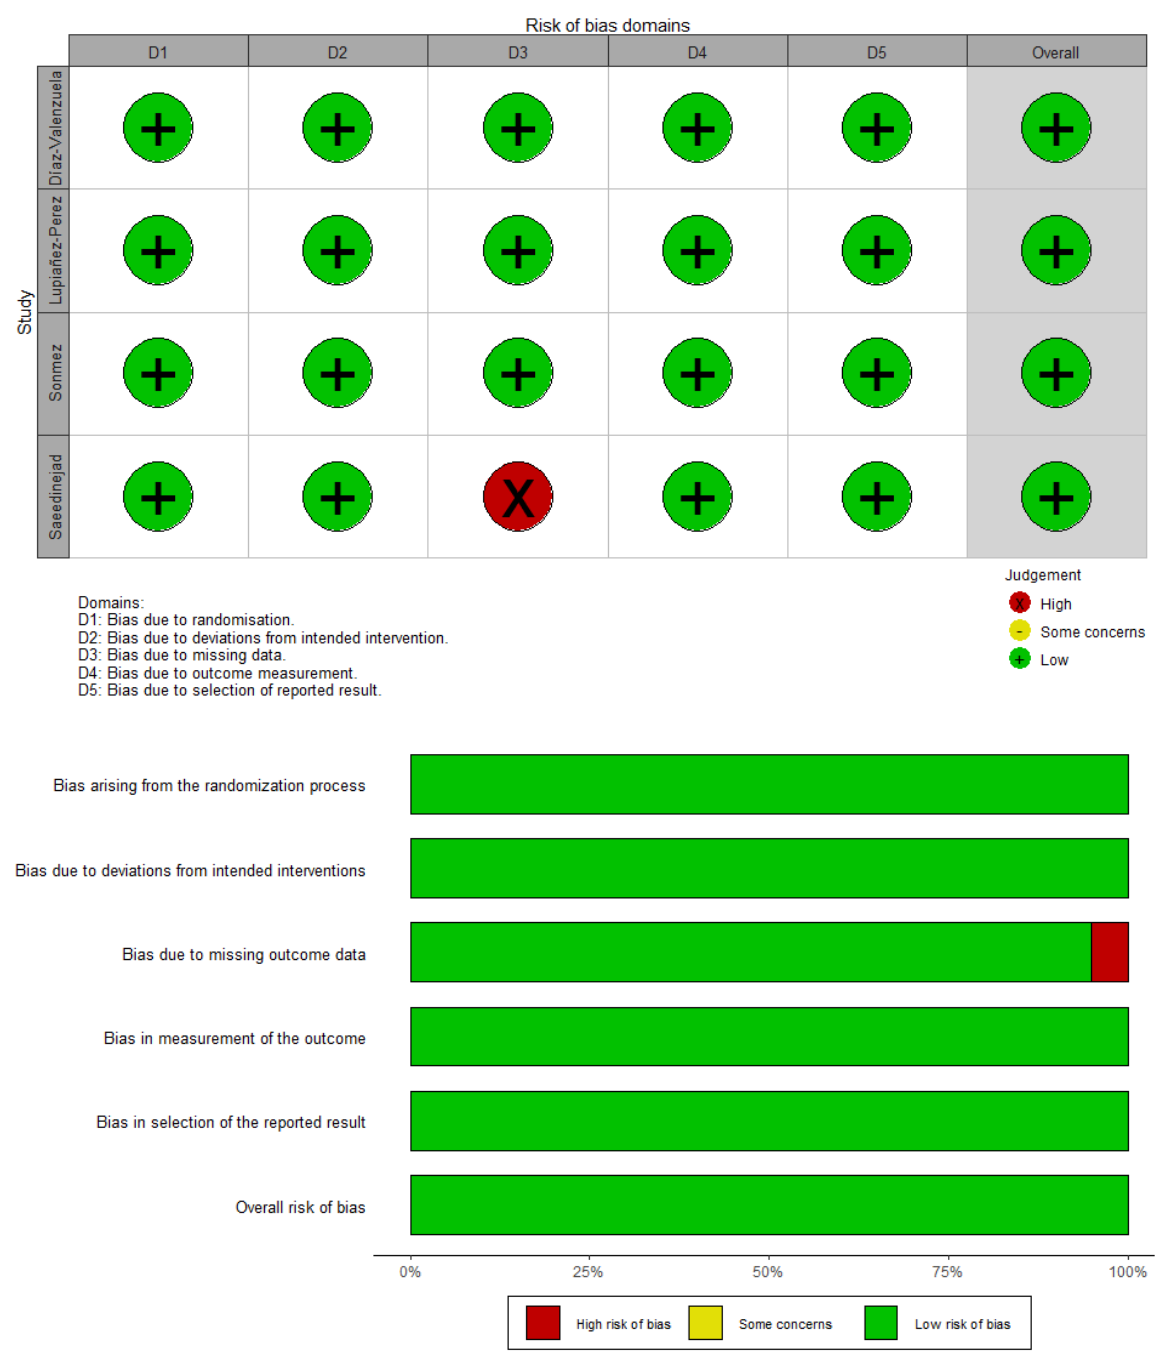
Figure 2. Risk of bias summary, assessed by RoB 2: authors’ judgments for each included study.